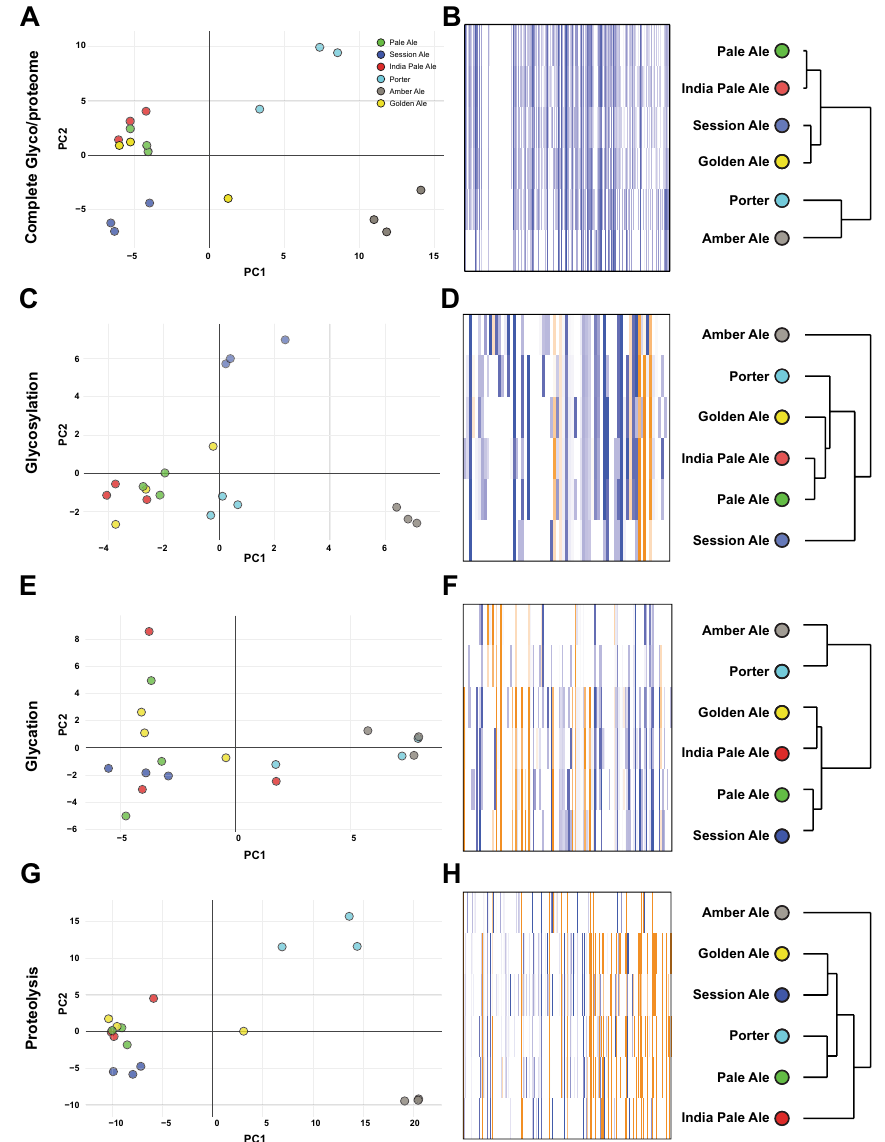
Figure 3. Analysis of beers from Newstead Brewing Co. ( A ) PCA (PC1 26.89% and PC2 13.80%) and ( B ) heat map of the complete glyco/proteome. ( C ) PCA (PC1 19.67% and PC2 14.01%) and ( D ) Heat map of the site- specific glycoproteome. ( E ) PCA (PC1 25.18% and PC2 9.31%) and ( F ) heat map of the site-specific glycated proteome. ( G ) PCA (PC1 24.72% and PC2 8.63%) and ( H ) heat map of the site-specific proteolytic proteome. PCAs and heatmaps use log 10 protein abundance normalised to total protein abundance in each sample. Dendrograms show sample clustering by beer